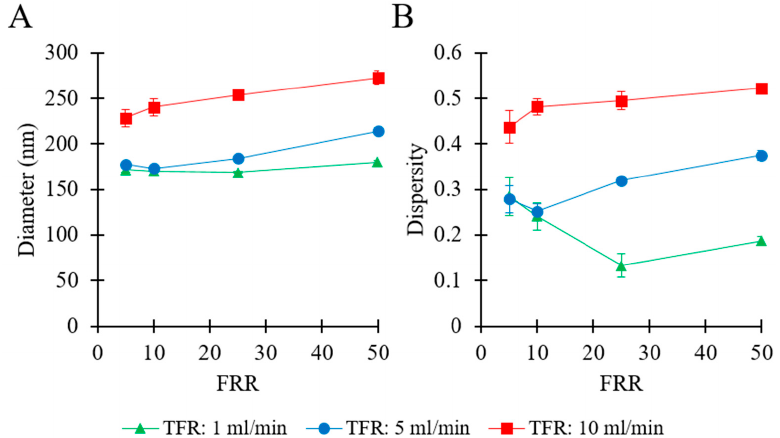
Figure 2. Effects of total flow rate (TFR) and flow rate ratio (FRR) on liposome Z-average size ( A ) and dispersity ( B ). Data represent the means of three measurements with corresponding standard